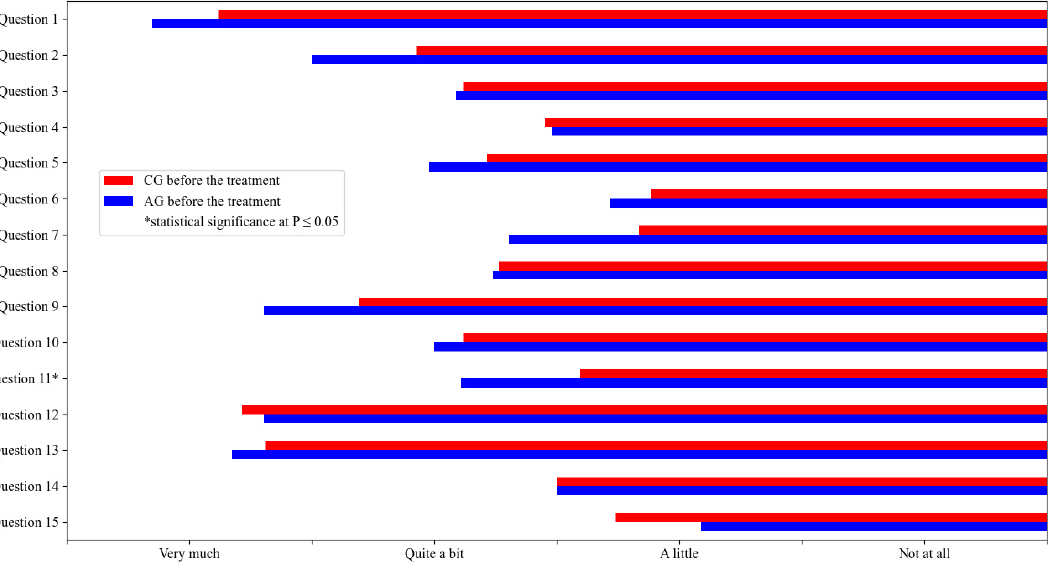
Figure 4. Statistical comparison of the quality of life of ASIT – treated dogs before the treatment (QoL1 AG) and dogs, not treated with ASIT, before the treatment (QoL1 CG). The mean values are represented in the figure and statistical significance at p ≤ 0.05 is marked with * .